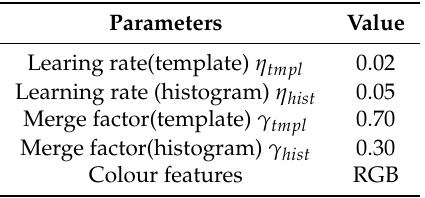
Table 1. Parameters used in our